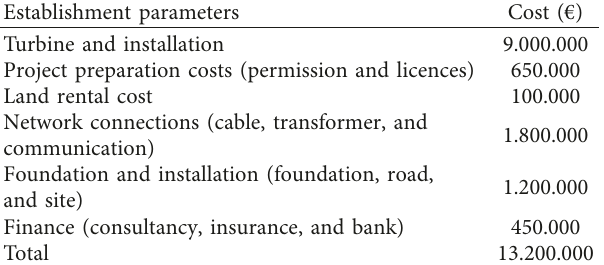
Table 6: Turbine establishment cost [20–26].